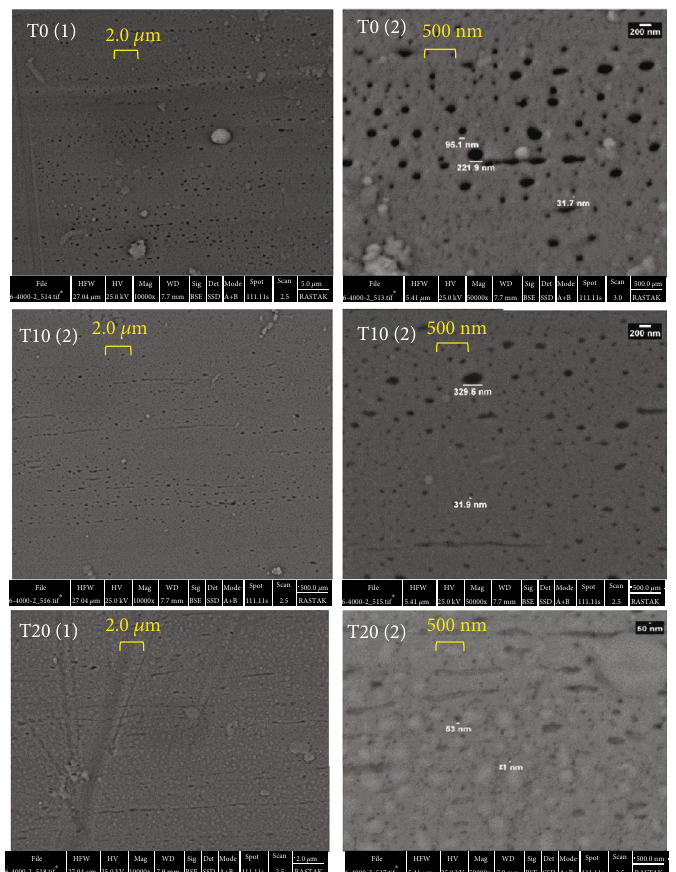
Figure 11: E ff ect of take-up speed on outer surface morphologies of PAN hollow fi bers: (a) 10000x magni fi cation; (b) 50000x magni fi cation (T0: free fall; T10: 10% stretch; T20: 20%